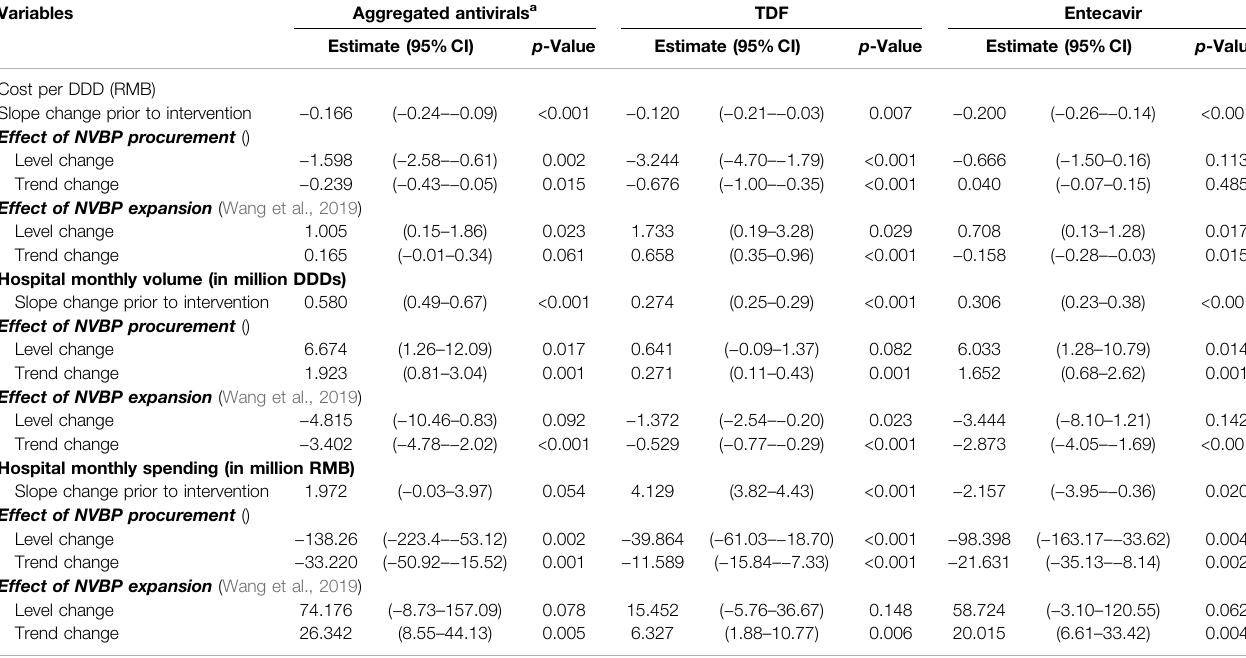
TABLE 1 | Changes in levels and trends of HBV antivirals on cost per DDD, procurement volume, and procurement spending for antivirals in “ 4+7 ″ pilot cities a . Variables